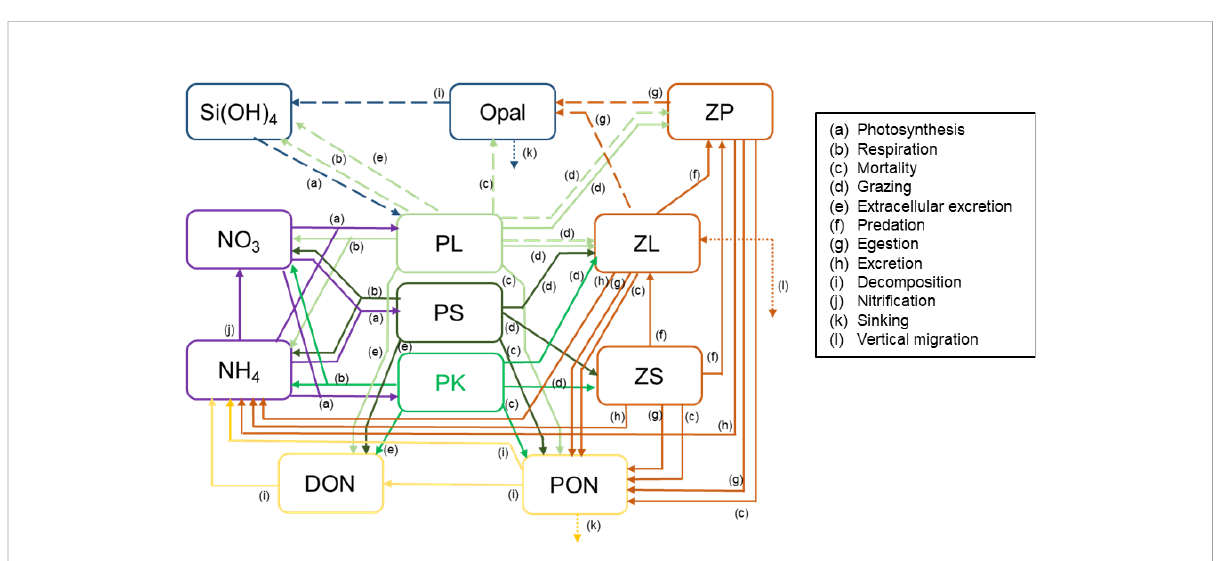
FIGURE 2 Schematic of the NEMURO + showing the 12 compartments and the processes linking them. Solid and dashed arrows indicate fl ows of nitrogen and silicon, respectively. Dotted arrows indicate the exchange or sinking of materials between the modeled box and the region below the mixed layer. PL, population of large phytoplankton (diatom); PK, phytoplankton population dominated by Karenia selliformis ; PS, population of phytoplankton other than PL and PK; ZL, population of large zooplankton; ZS, population of small zooplankton; ZP, population of predatory zooplankton; NO 3, nitrate; NH 4 , ammonium; Si(OH) 4 , silicate; PON, particulate organic nitrogen; Opal, biogenic silica; DON, dissolved organic